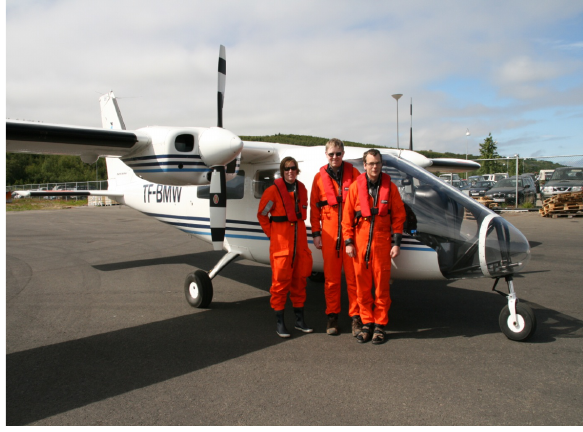
Figure 10. Observer team, Iceland, 2007 (Photo D. G.